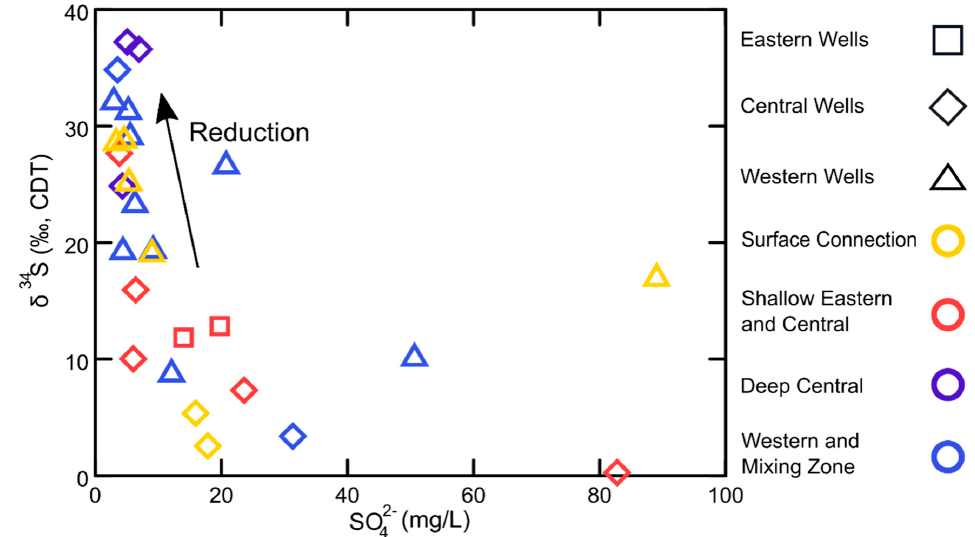
Figure 6. Measured values of δ 34 S and sulfate (SO 4 ) concentrations for groundwater samples collected from wells in the South Fork Palouse River Basin.